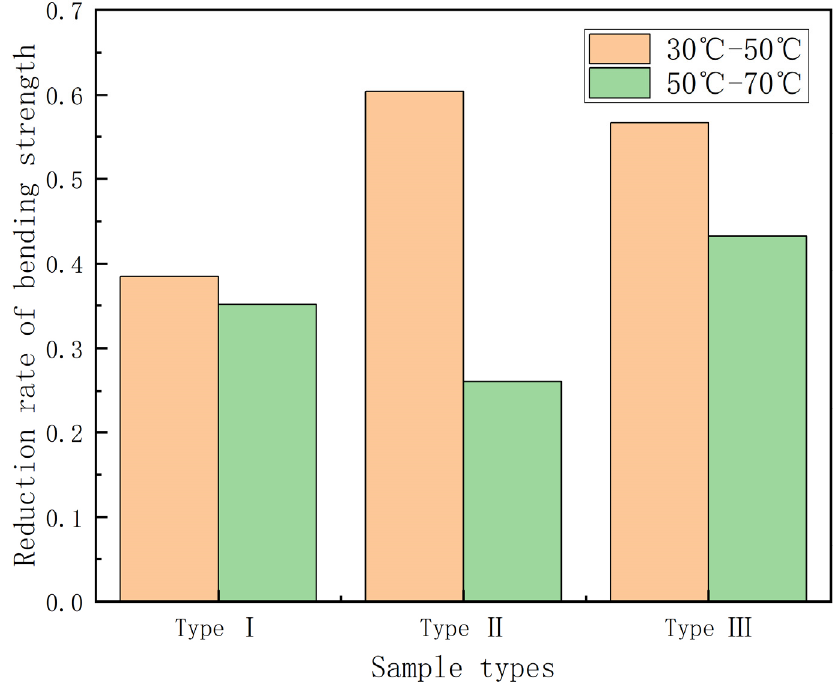
Figure 9. Bending strength reduction rate–temperature increment histogram.